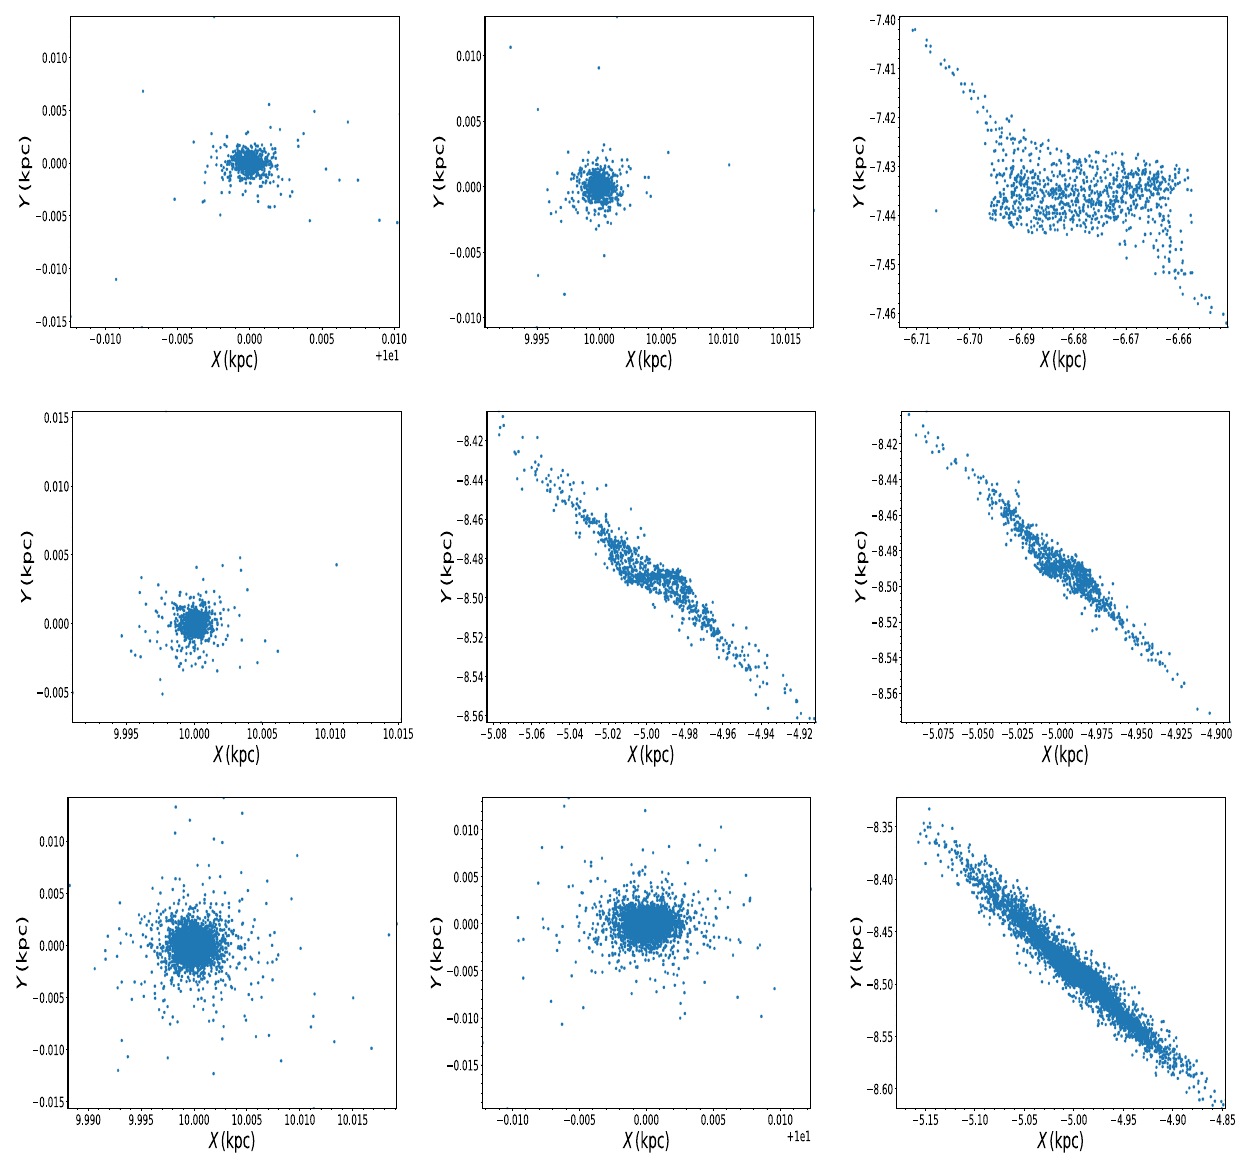
Fig. 4 Numerical simulations of Weyl potential with Miyamoto-Nagai potential (top panels) and the conjunction of Weyl potential and MWpotential2014 in middle and bottom panels for different cluster masses and radii (cases (1) and (2), respectively.) in early stages of